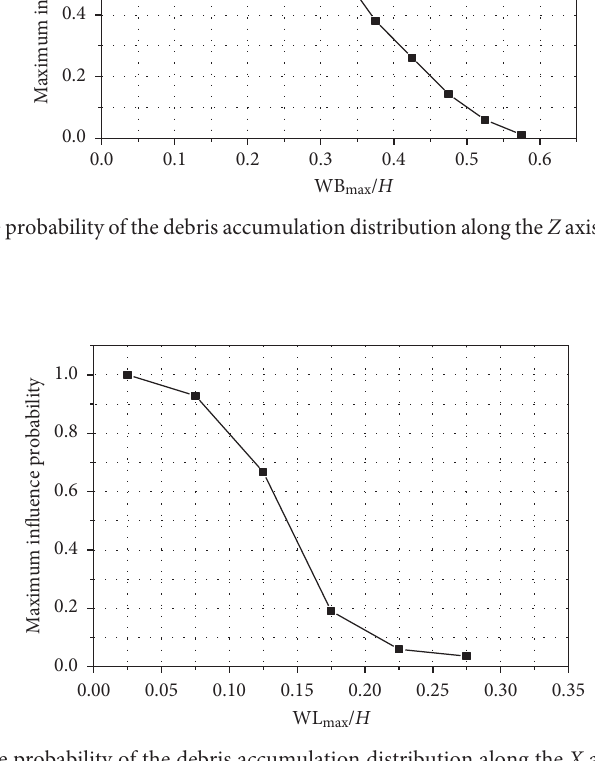
Figure 23: The maximum influence probability of the debris accumulation distribution along the X axis under the continuous collapse of the masonry structure.